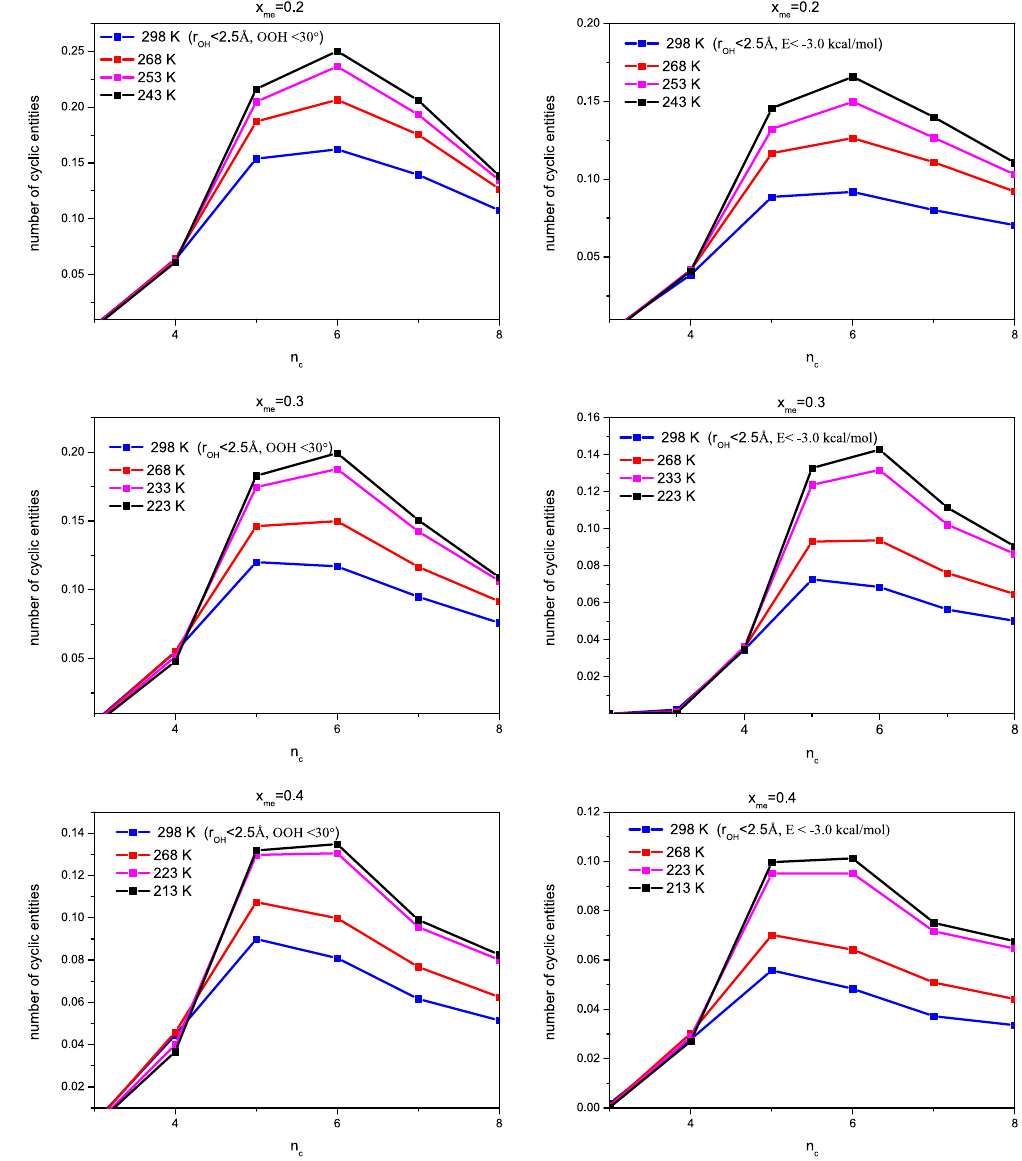
Figure 3. Ring size distributions, normalized by the number of molecules in the simulated systems, for the three mixtures (upper panels: X M = 0.2; middle panels: X M = 0.3; lower panels: X M = 0.4), as a function of temperature. Left panels: geometric definition of hydrogen bonds; right panels: energetic definition. Sixfold rings become the most abundant at the lowest temperature (LT2) at each methanol content; also, their abundance nearly doubles at the lowest temperatures in comparison with room temperature